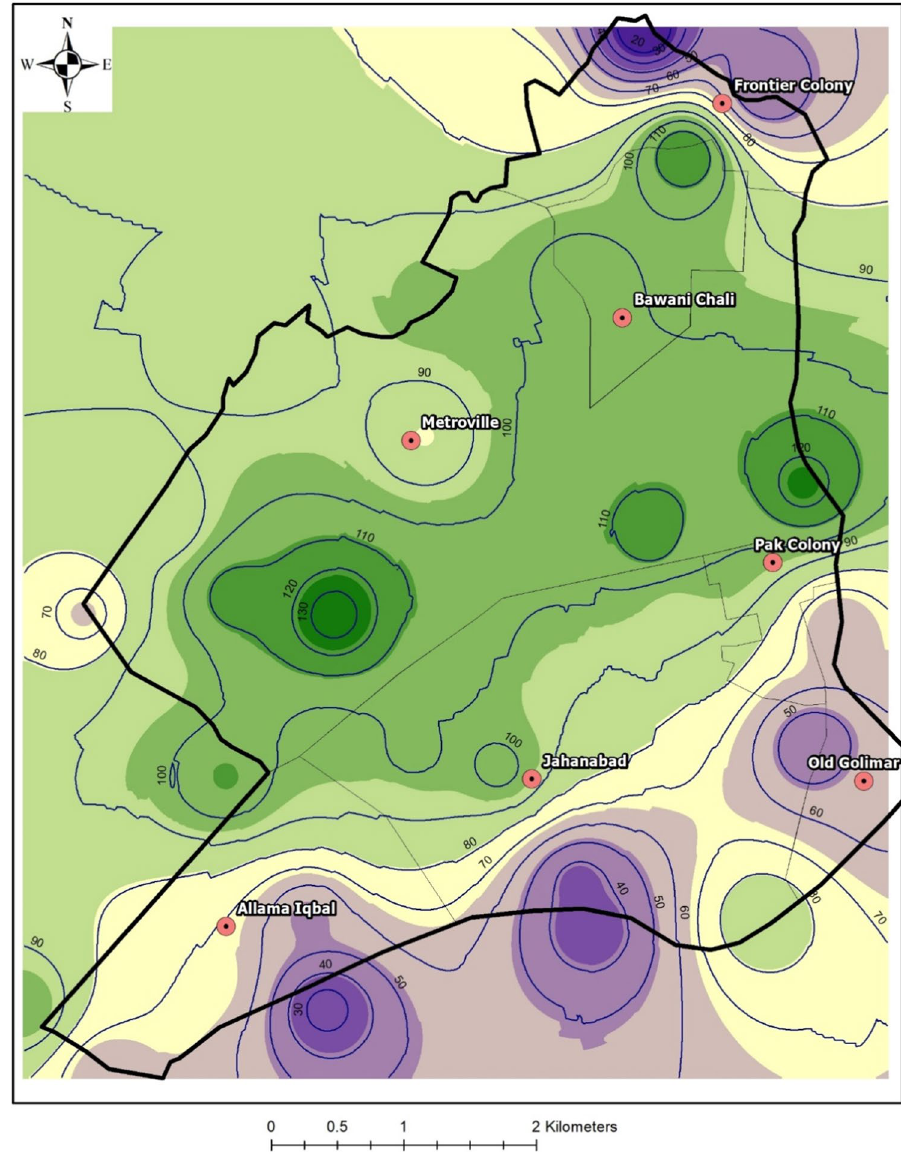
Fig. 15 Groundwater table map of union councils of SITE